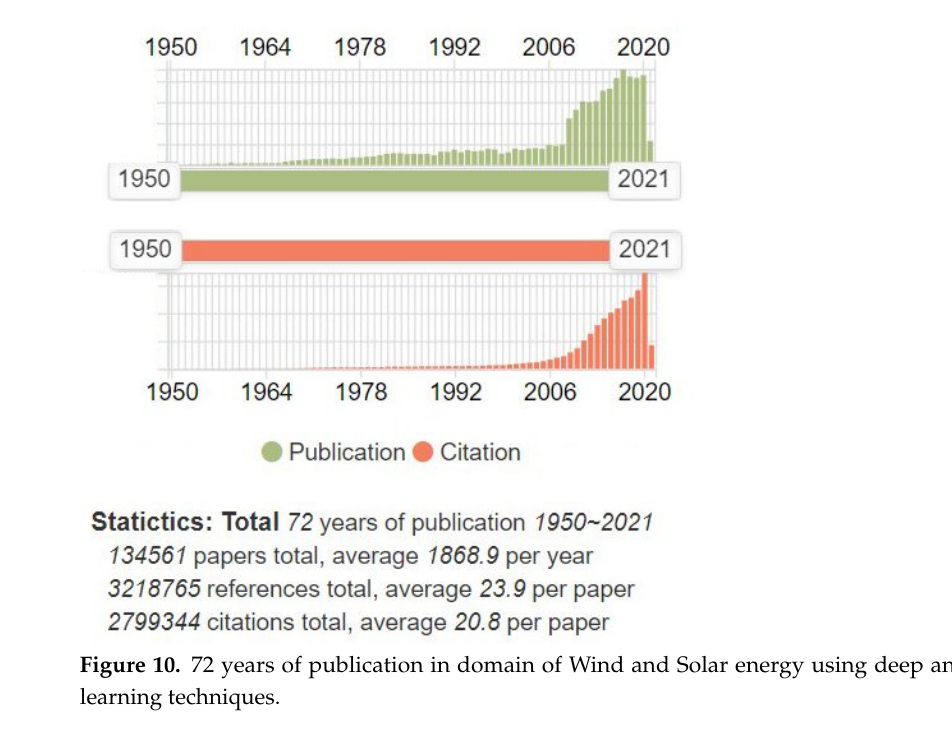
Figure 10. 72 years of publication in domain of Wind and Solar energy using deep and machine learning